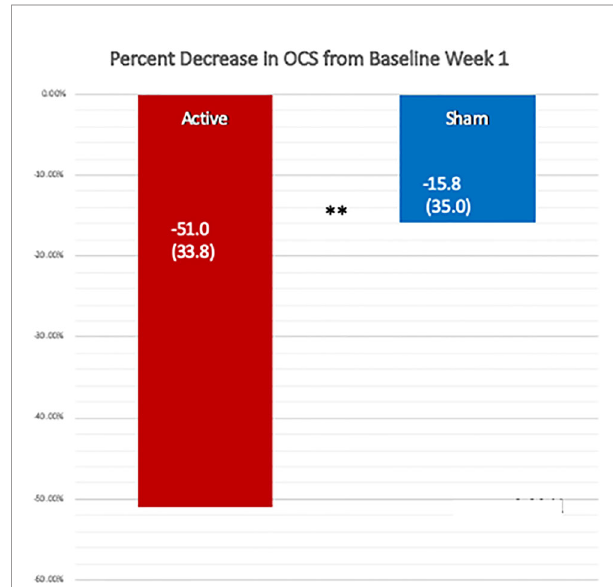
TABLE 4 | Comparison of Clinically Meaningful Improvement in Mean OCS Between Active and Sham Treatments One Week After Treatment. _ Active Sham P-value (n = 17) (n = 17) Patients with decrease in OCS of at least 0.0289 60% from baseline, n (%) All Randomized Patients with Complete Data. [1] Clinically meaningful improvement in mean OCS was de fi ned as a percent decrease from baseline (pre-treatment week 1) of at least 60%. [2]McNemar ’